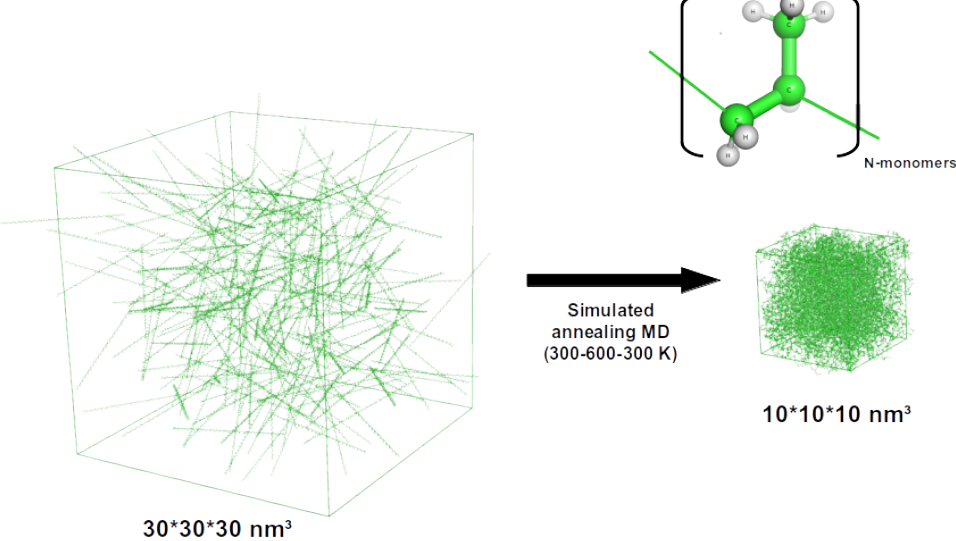
Figure 2. Illustration of the atomistic models used for pure PP systems. The dense PP unit cell on the right is generated using matchstick-like PP chains in a large box ( left ) and running multiple annealing cycles to allow the chains to entangle while achieving a target density of 0.85 g cm − 3 ( right ).